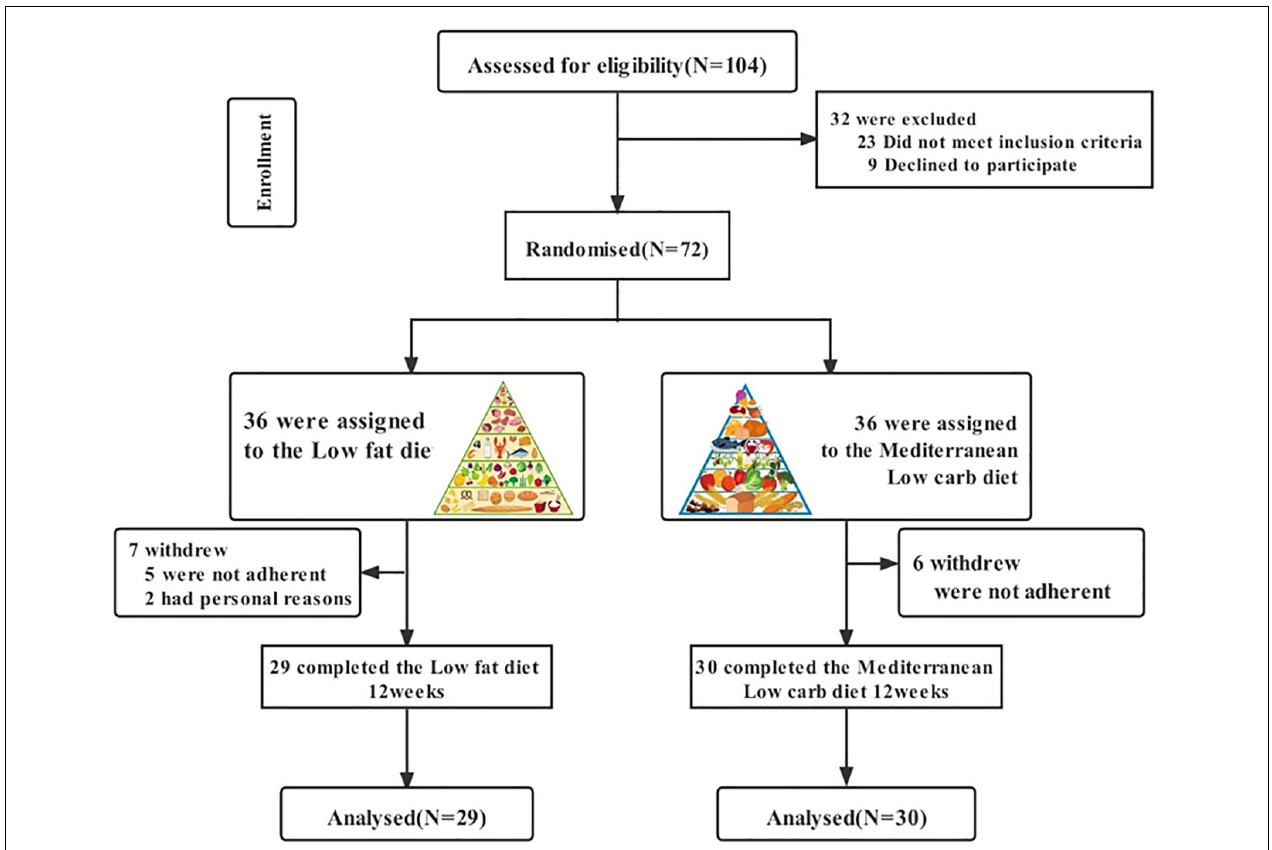
FIGURE 1 | Flow chart from the study